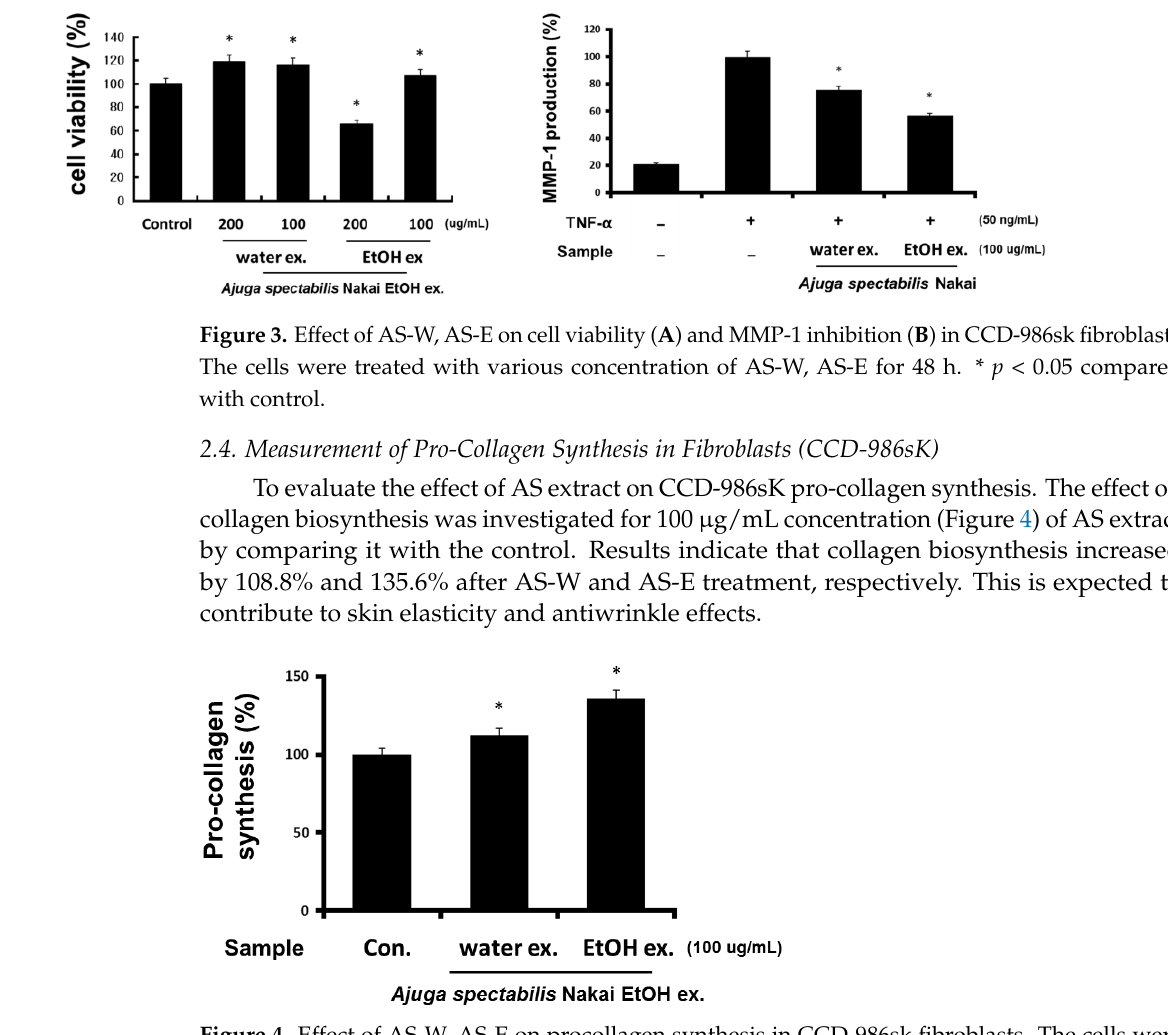
Figure 4. Effect of AS-W, AS-E on procollagen synthesis in CCD-986sk fibroblasts. The cells were incubated for 24 h in DMEM medium containing 10% FBS, followed by incubation with various concentrations of AS-W and AS-E for 48 h. * p < 0.05 compared with control.